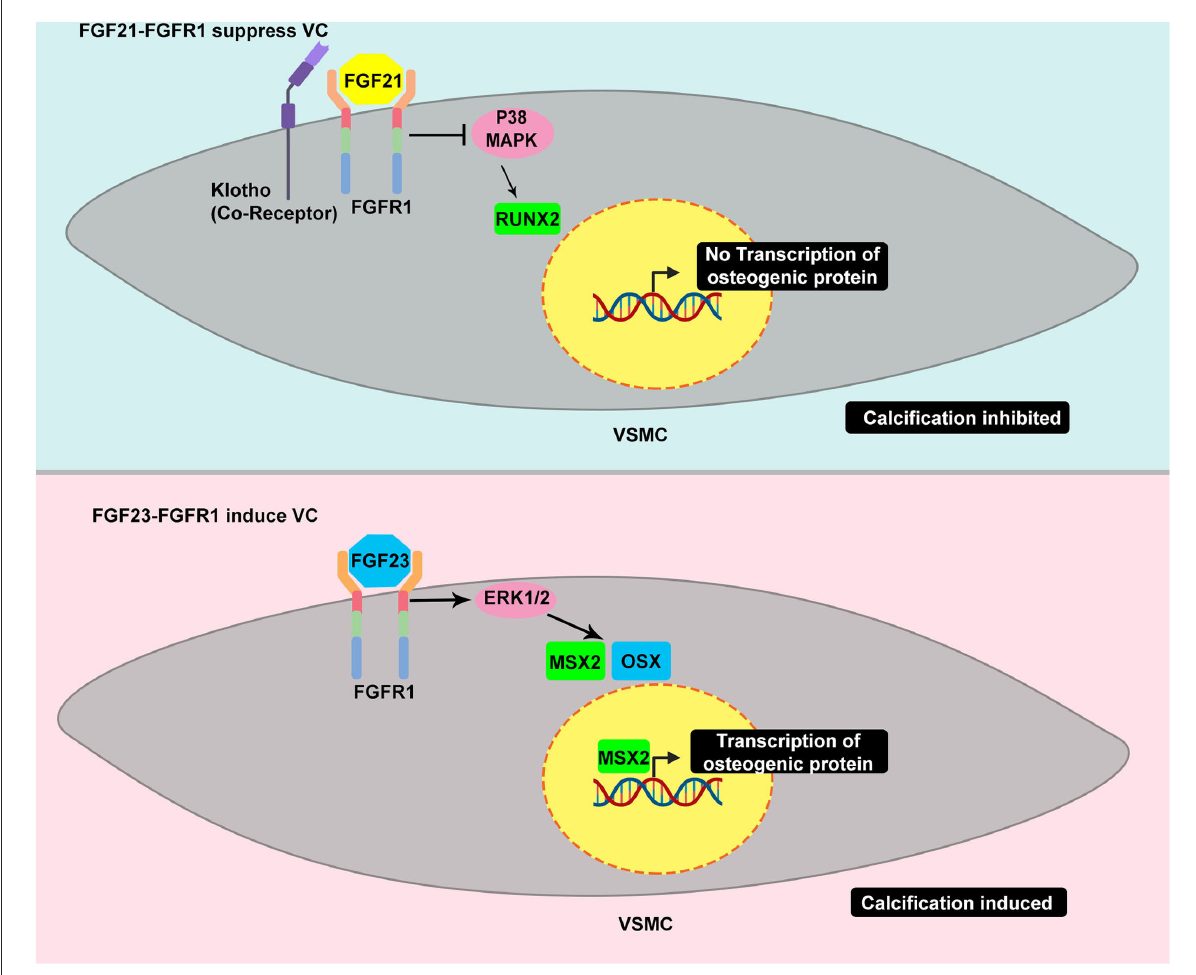
FIGURE4 Example of TRK induced by different ligand yields different response in VC – the dual roles of TRK in vascular calcification. FGFR1 activated by FGF21 suppresses the calcification, in part, through the inhibition of p38 MAPK. The p38 MAPK induces the increase of RUNX2 which is considered as master regulator of osteoblast-like differentiation. The decrease of RUNX2 eventually affects the VSMC to osteoblastic-like cell reprogramming leading to calcification suppression (upper panel) . In contrast, FGFR1 activated by FGF23 results in different responses.